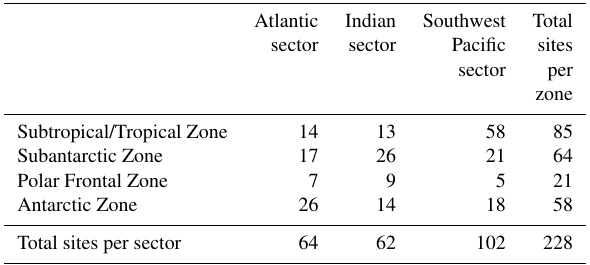
Table 2. Number of sites located in each zone and sector of the Southern